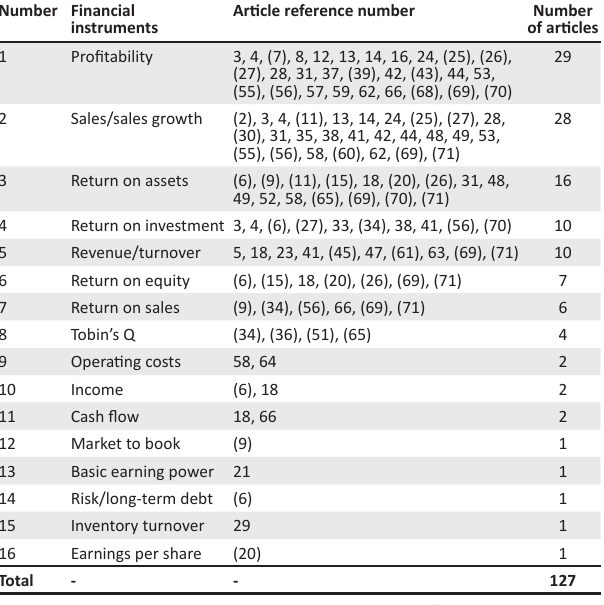
TABLE 2: Financial instruments used to measure organisational performance. Number Financial instruments